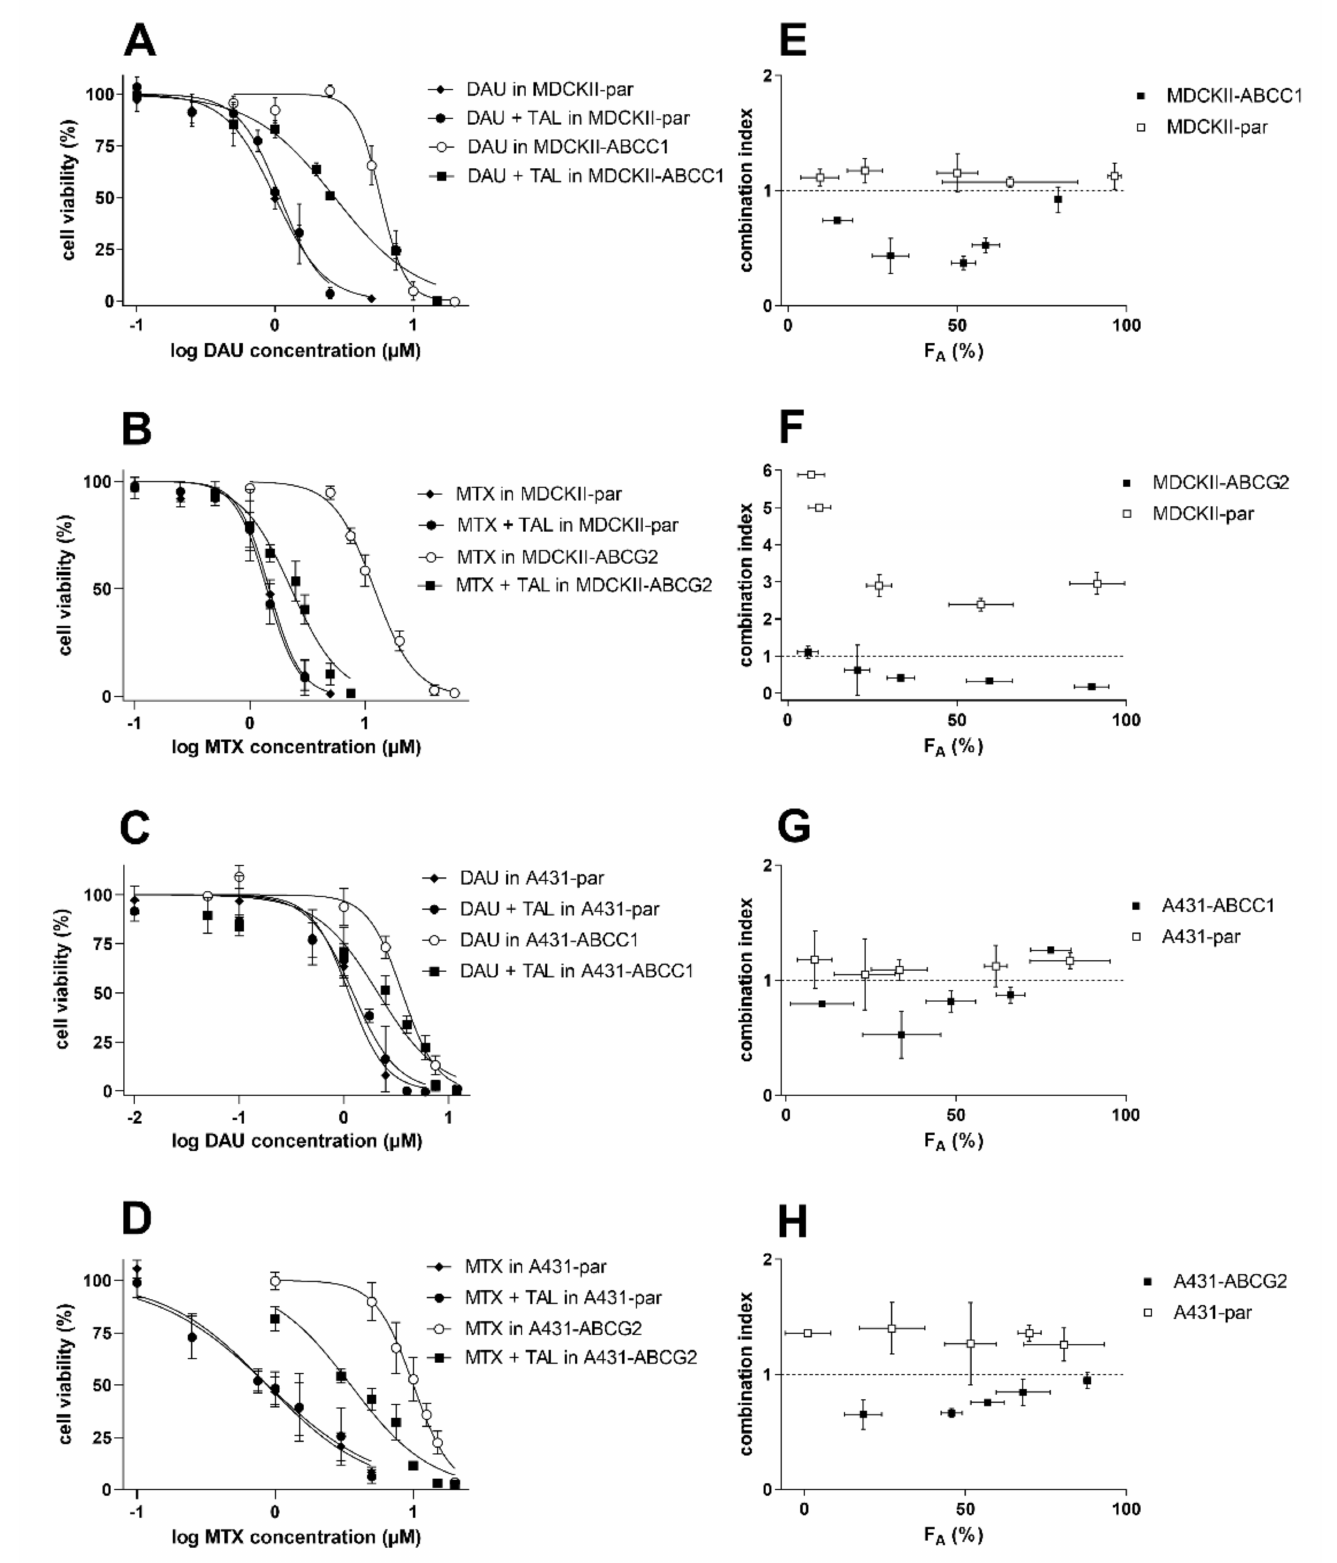
Figure 6. The influence of 5 µ M talazoparib on cytotoxic effect of daunorubicin in ( A ) MDCKII- ABCC1 and ( C ) A431-ABCC1, or with mitoxantrone in ( B ) MDCKII-ABCG2 and ( D )